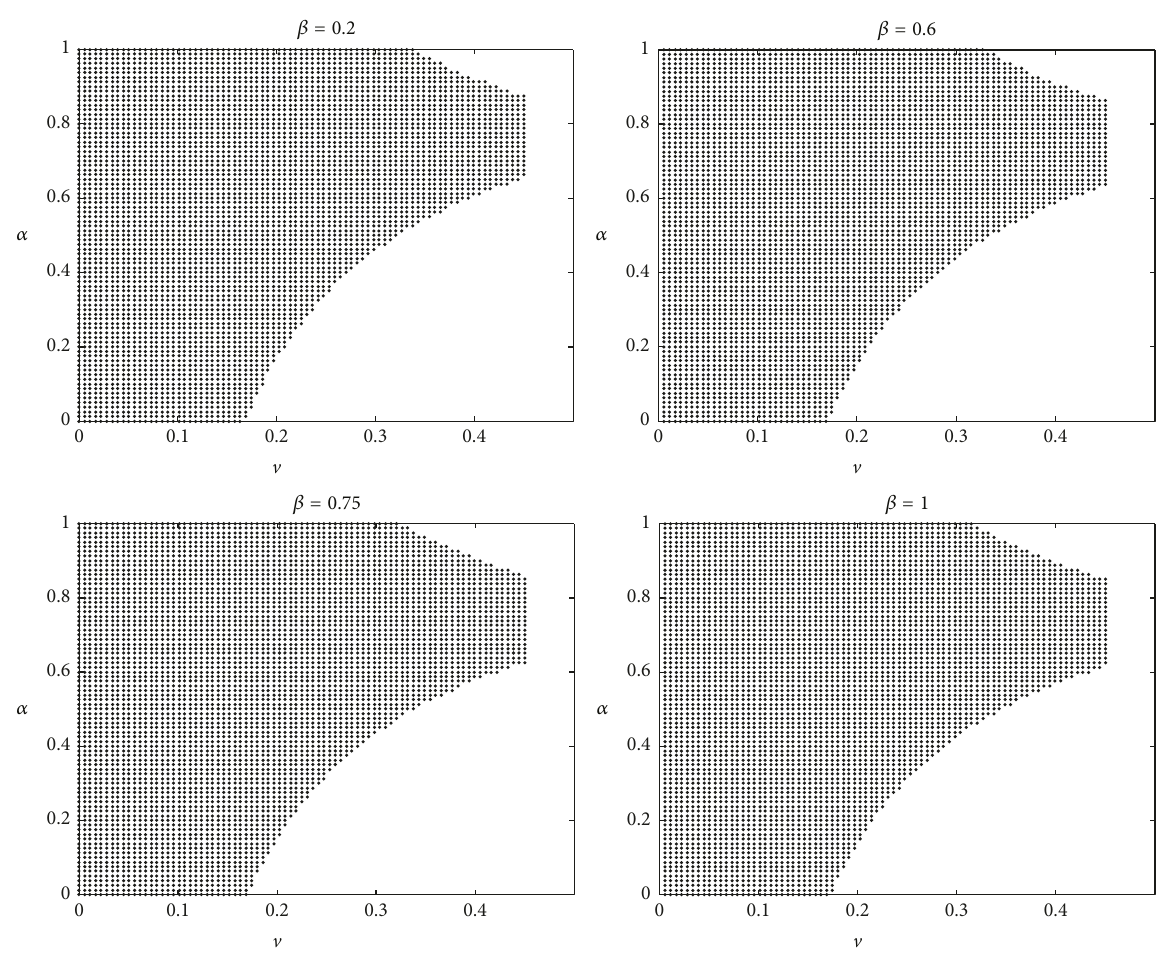
Figure 2: Stability regions in the ( V , 𝛼) -plane for different levels of 𝛽 .